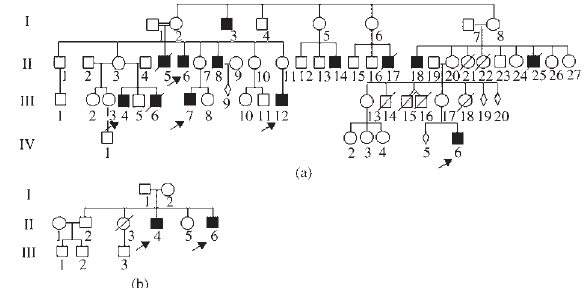
Figure 1 - Heredograms of ( a ) family 1 and ( b ) family 2 with X-linked KS. Affected males. Arrows indicate patients clinically examined in this study.